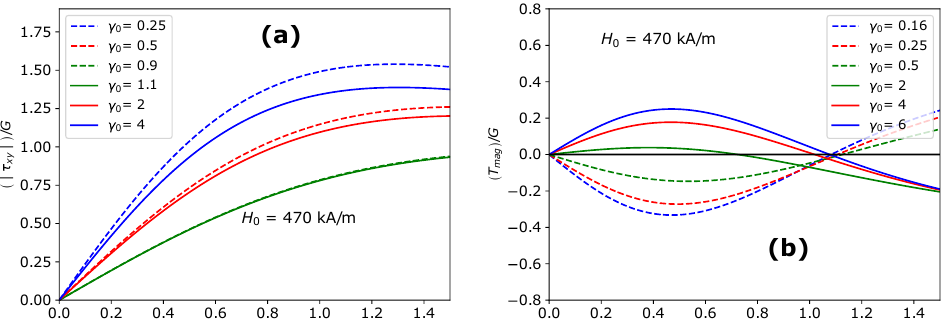
Figure 5. ( a ) The magnetic torque τ xy as a function of the amount of shear k during shear deformation along the field direction (dashed lines) and perpendicular to the field direc- tion (solid lines) for different values of the initial aspect ratio γ 0 . ( b ) The magnetic stress (cid:16) (cid:17) 1 + τ xy − ( E 3 ) T mag = ζ ( S 1 E 1 + S 2 E 2 ) as a function of the amount of shear k during shear xy xy 2 deformation along the field direction (dashed lines) and perpendicular to the field direction (solid lines) for different values of the initial aspect ratio γ 0